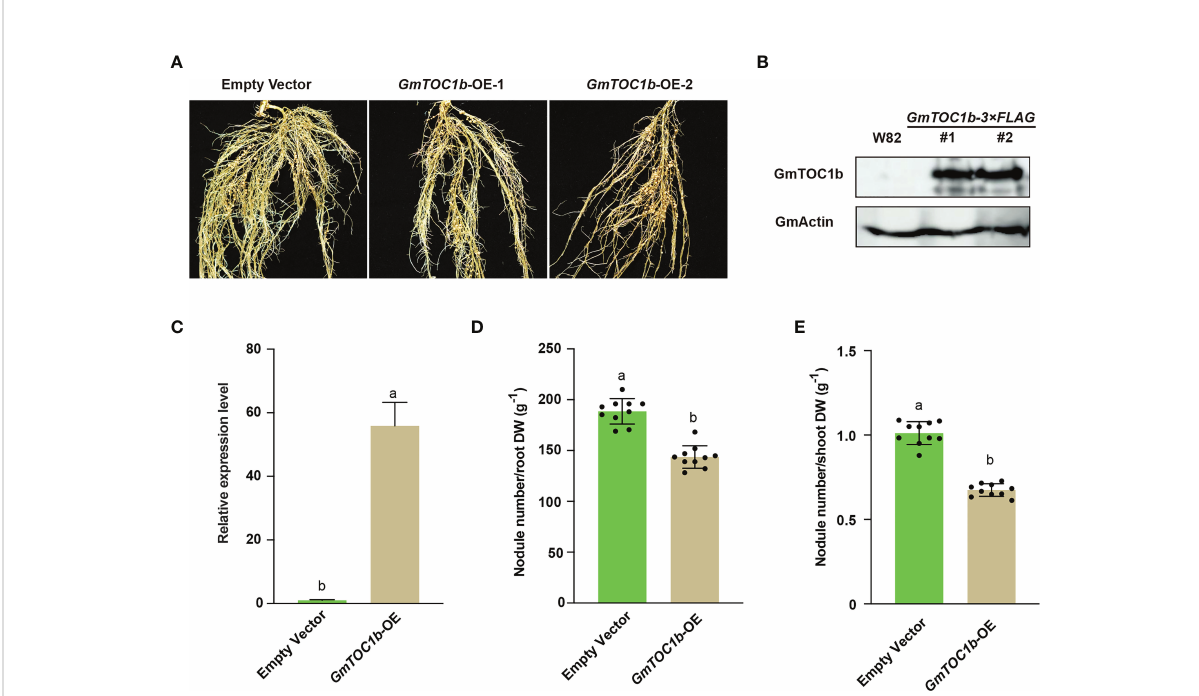
FIGURE 4 Overexpression of GmTOC1b in transgenic hairy roots inhibits nodulation. (A) Representative nodulation phenotype of GmTOC1b- OE and empty vector control transgenic hairy roots at 14 DAI. (B) Immunoblot analysis of GmTOC1b abundance in W82 and GmTOC1b-3Flag transgenic hairy roots. An anti-Flag antibody was used to recognize GmTOC1b-3Flag; actin was used as loading control. (C) Relative GmTOC1b transcript levels in GmTOC1b- OE and empty vector control transgenic hairy roots. Relative expression level was calculated as the ratio of the expression value of the target gene to that of reference gene GmActin as an internal standard. (D, E) Nodule number per gram of root dry weight or shoot dry weight in GmTOC1b- OE and empty vector control transgenic hairy roots at 14 DAI (n = 10). Different lowercase letters indicate signi fi cant differences as determined by Student ’ s t